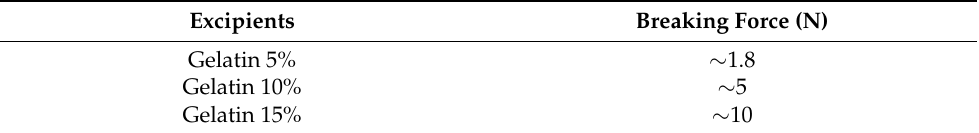
Table 2. Pre-formulation test on the impact of gelatin on hardness of gummy formulations